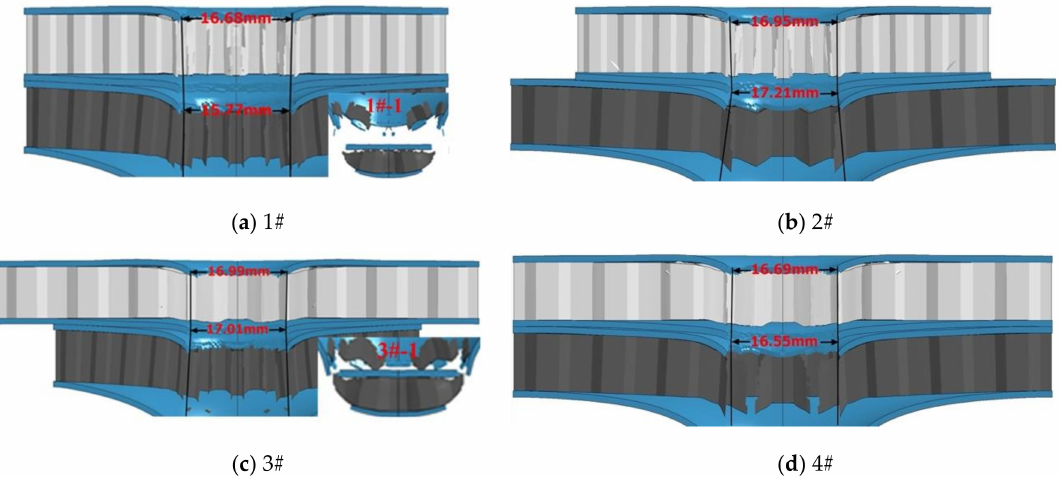
Figure 4. Damage results of 1#–4# structure. ( a ) Damage result of 1# structure; ( b ) Damage result of 2# structure; ( c ) Damage result of 3# structure; ( d ) Damage result of 4#